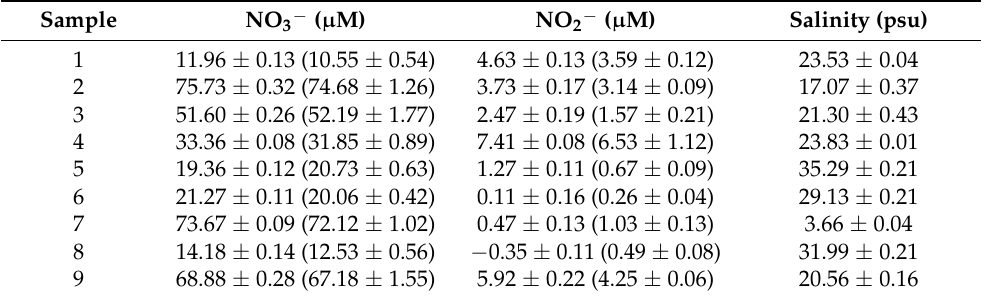
Table 4. The predicted values of NO 3 − , NO 2 − , and salinity (average ± 1 standard deviation of three replicate analyses) using the PLS2 model in seawater samples of the Changjiang Estuary.